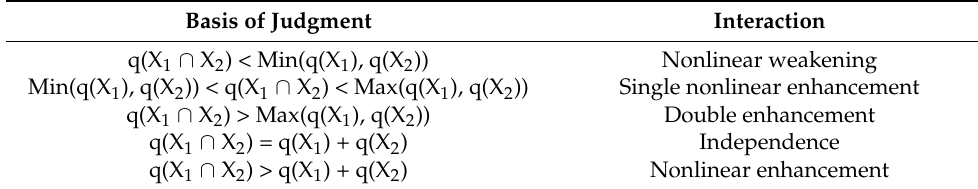
Table 4. The basis for judging two-factor interaction